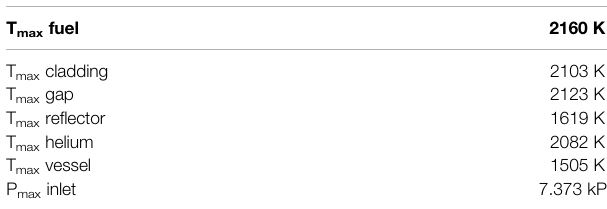
TABLE 6 | Main calculation